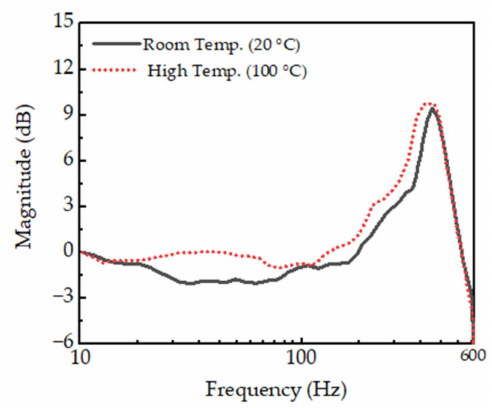
Figure 14. Frequency response of the spool with the excitation magnitude of ± 0.15